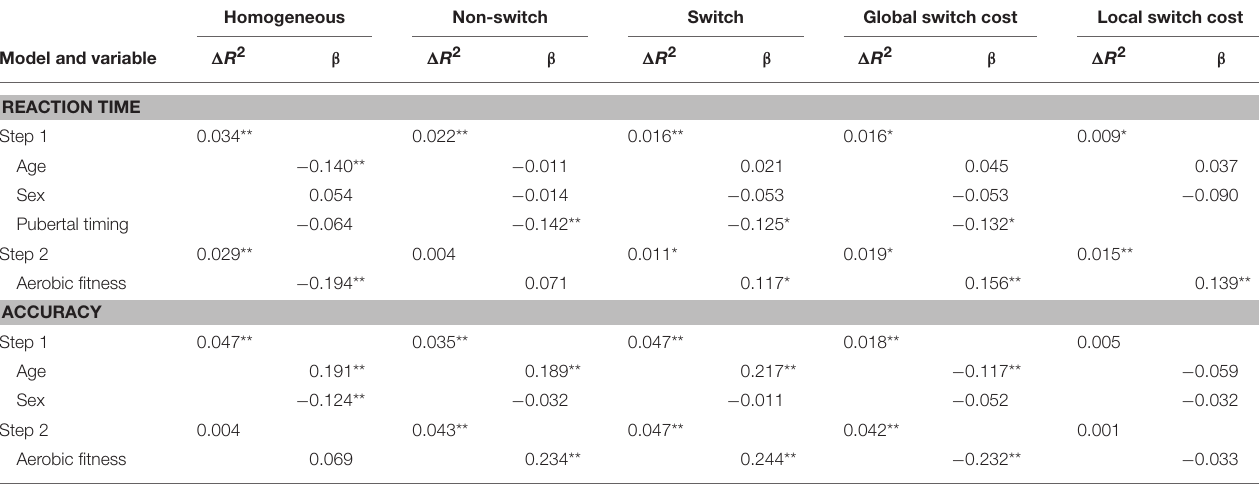
TABLE 4 | Summary of Hierarchical Regression Analyses for Switch Reaction Time and Accuracy. Homogeneous